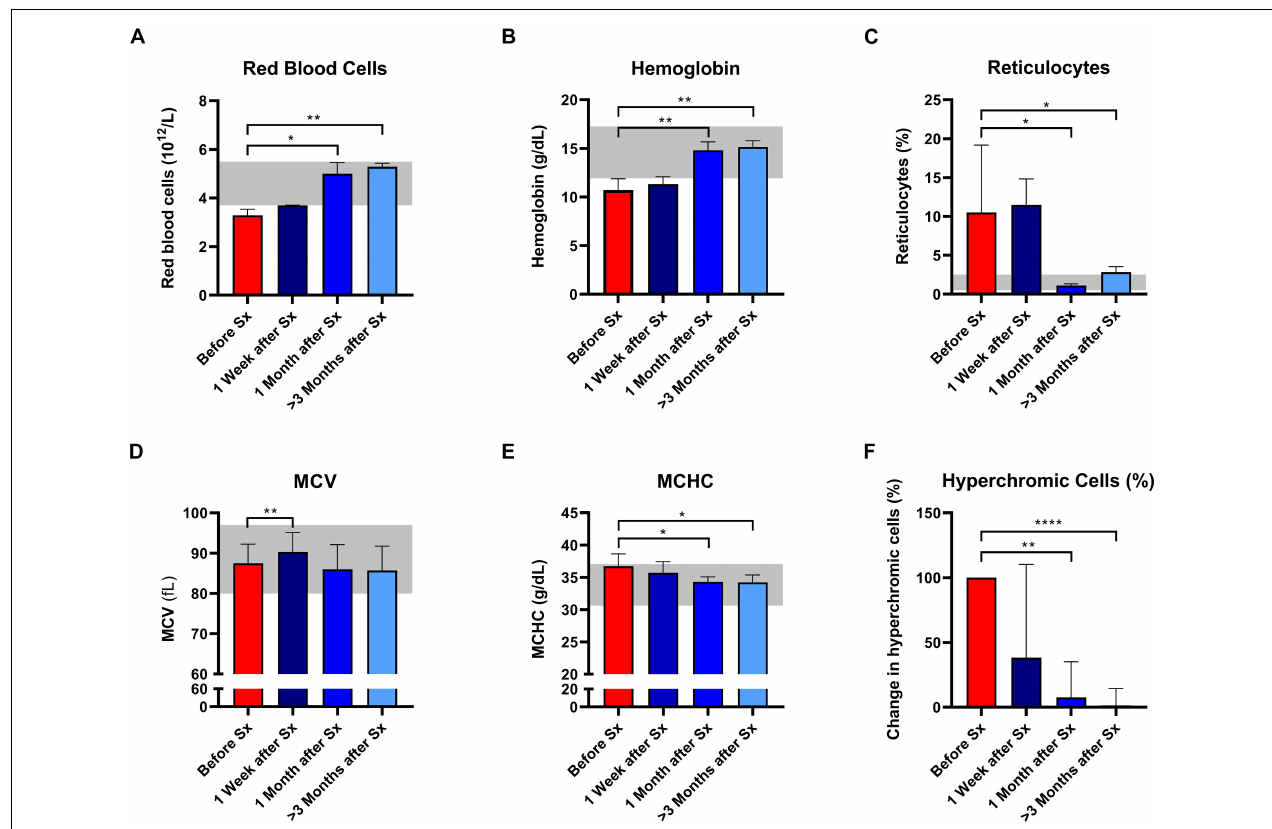
FIGURE 1 | Red blood cell related parameters of patients with hereditary spherocytosis (HS) before and after splenectomy (Sx). Whole blood of HS patients ( n = 5) was analyzed before and 1 week, 1 and 3 months after splenectomy. (A) Red Blood Cells significantly increased after splenectomy. (B) Mean hemoglobin values significantly increased after 1 and 3 months after splenectomy. (C) Mean values of reticulocytes decreased 1 and 3 months after splenectomy. (D) mean values of mean corpuscular volume (MCV) increased significantly 1 week after splenectomy but decreased 1 and 3 months after splenectomy. (E) Mean values of mean corpuscular hemoglobin concentration (MCHC) decreased significantly 1 and 3 months after splenectomy. (F) Mean change in hyperchromic cells (%) after splenectomy. The laboratory reference ranges (2SD) of the University Medical Center Utrecht (UMCU) are depicted in the light gray area. Error bars represent standard deviation. **** p < 0.0001, *** p < 0.001, ** p < 0.01, and * p ≤